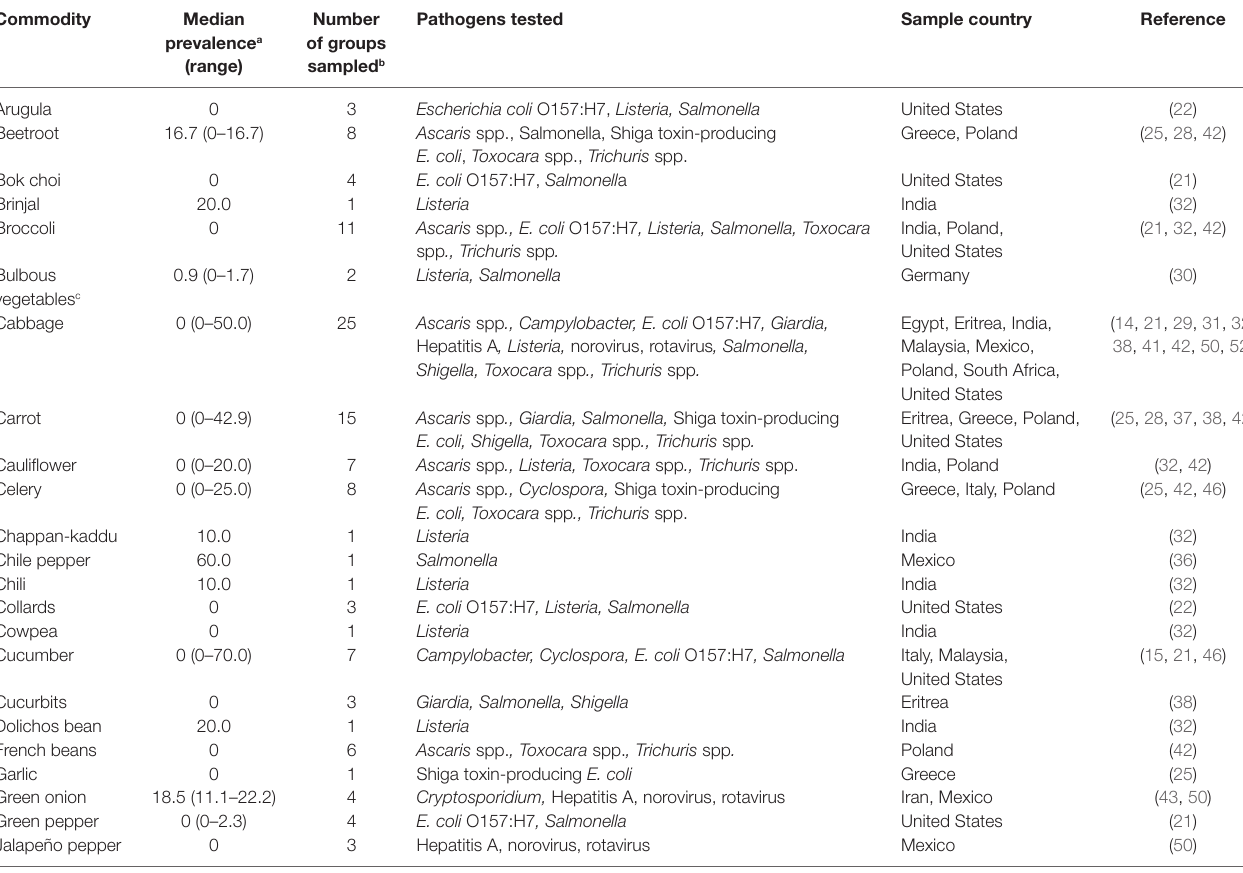
tabLe 6 | Pathogen prevalence by vegetable